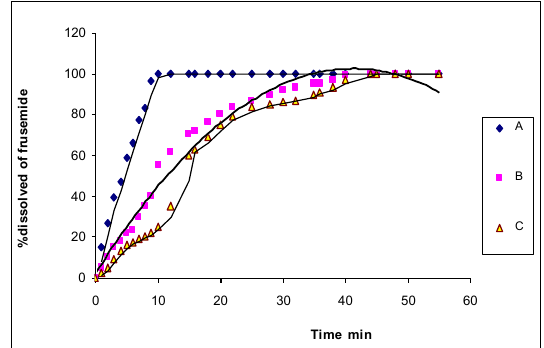
(B) Figure (7) : Dissolution rate profile of frusemide